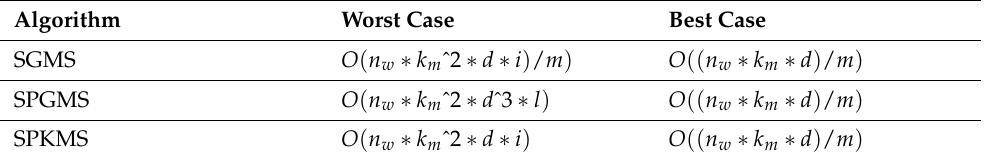
Table 2. Asymptotic computational complexity analysis of the model-based